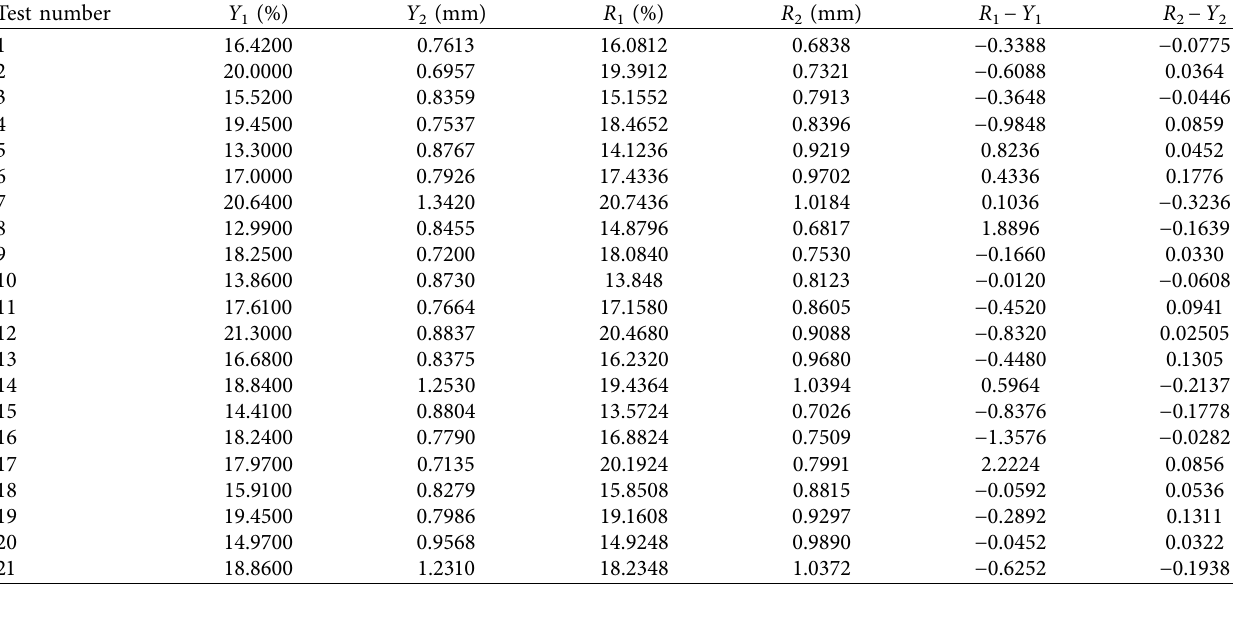
Table 10: Table of comparison between experimental and observed values.